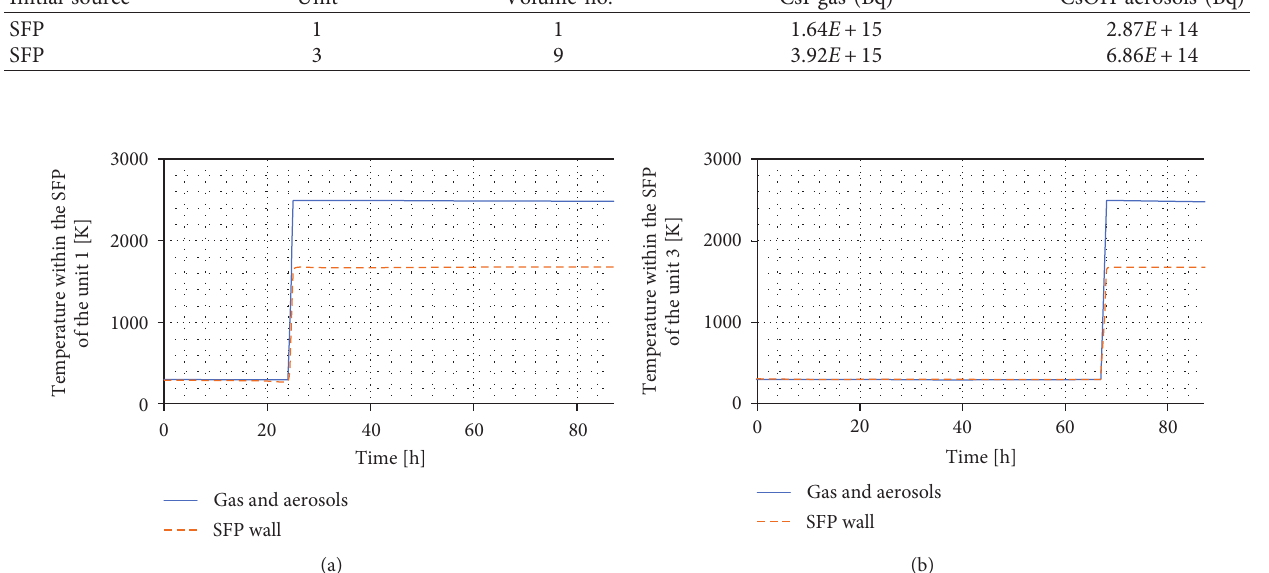
Figure 8: Temperatures of the gas and aerosols of cesium compounds and the SFP walls used for calculation in Modified ART Mod 2. (a) Unit 1. (b) Unit 3.